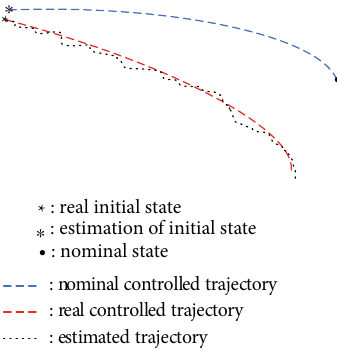
Figure 2: The nominal and real controlled trajectories by (cid:1) U . Figure